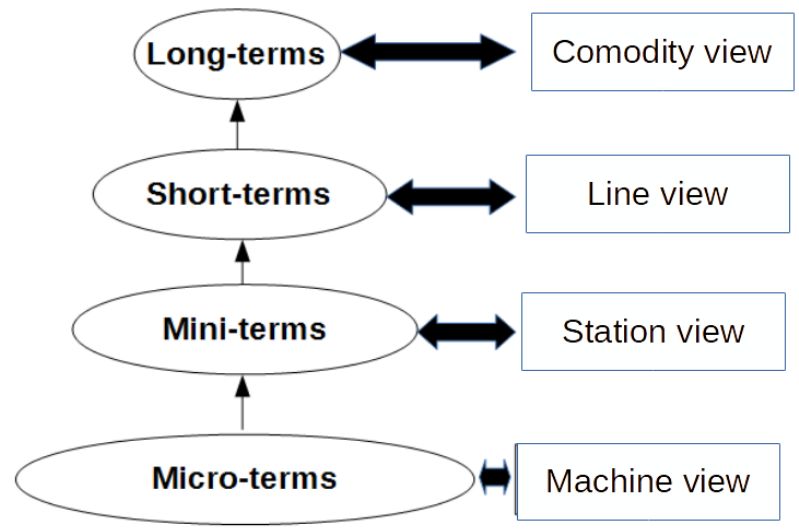
Figure 4. Data flow in manufacturing